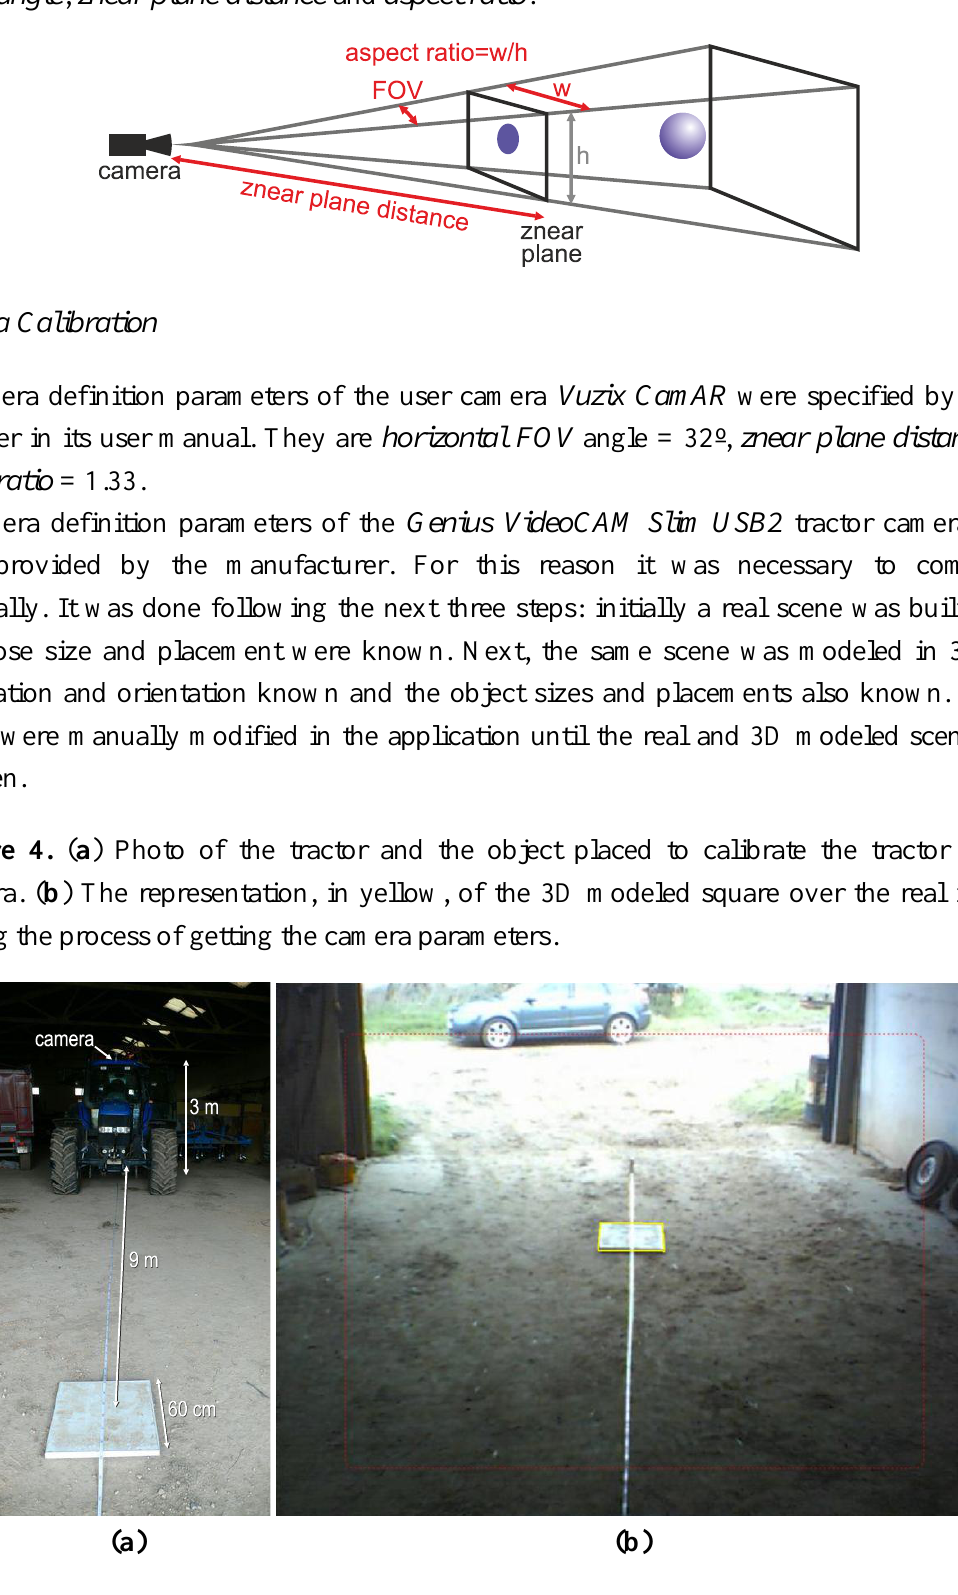
Figure 3. Camera view fustum showing in red the camera definition parameters: horizontal FOV angle , znear plane distance and aspect ratio .